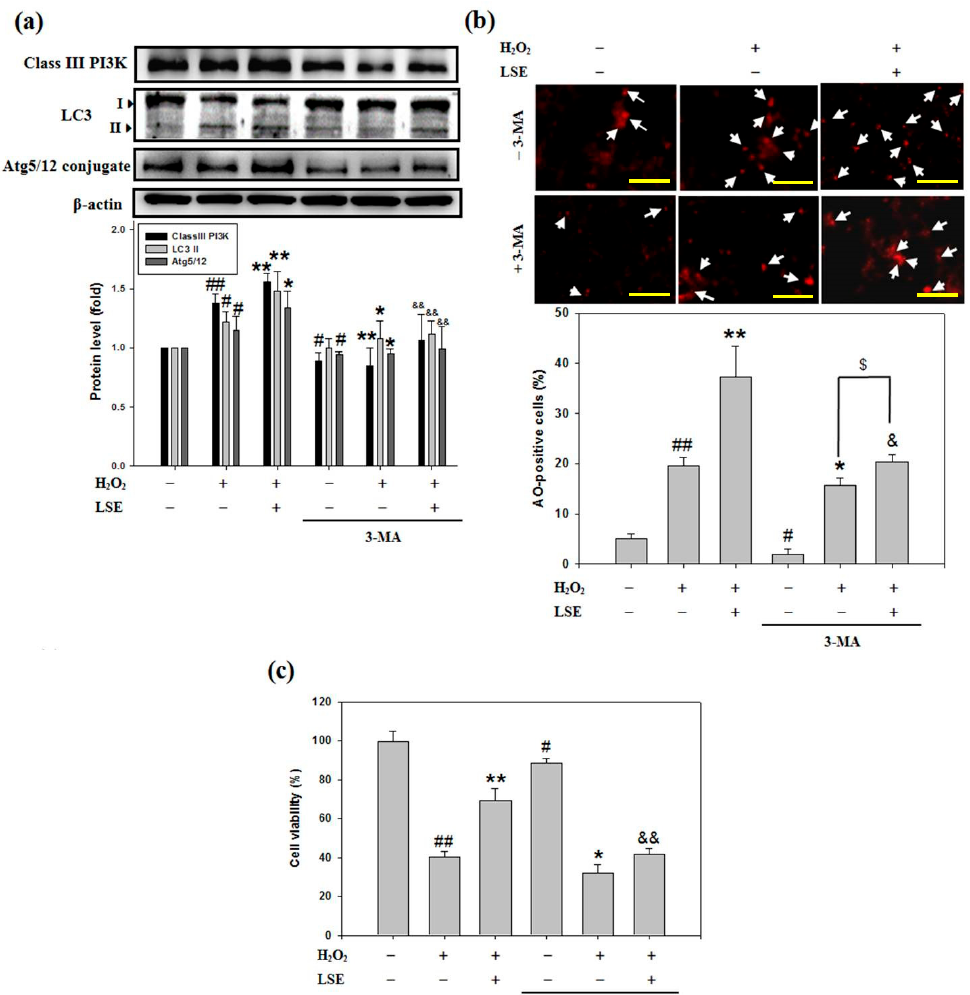
Figure 5. E ff ect of 3-methyladenine (3-MA) on LSE-induced autophagy and survival in the H 2 O 2 - treated beta-cells. RIN-m5F cells were pretreated with 3-MA (2 mM), then treated with or without